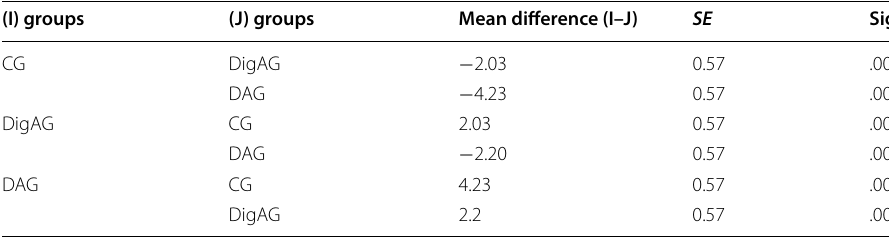
Table 5 Comparing speaking fluency posttest of all groups by using a Scheffe test